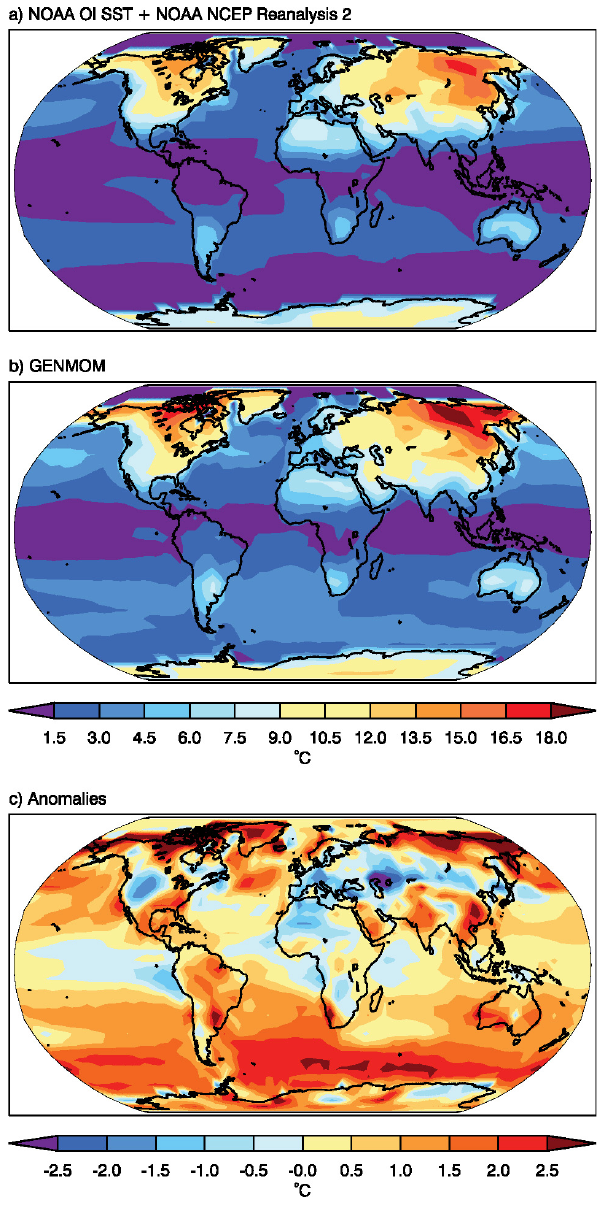
Fig. 5. Observed and modeled seasonal cycle amplitude of sur- face temperature and anomalies. The amplitude of the seasonal cy- cle is calculated as the standard deviation of the 12 climatological